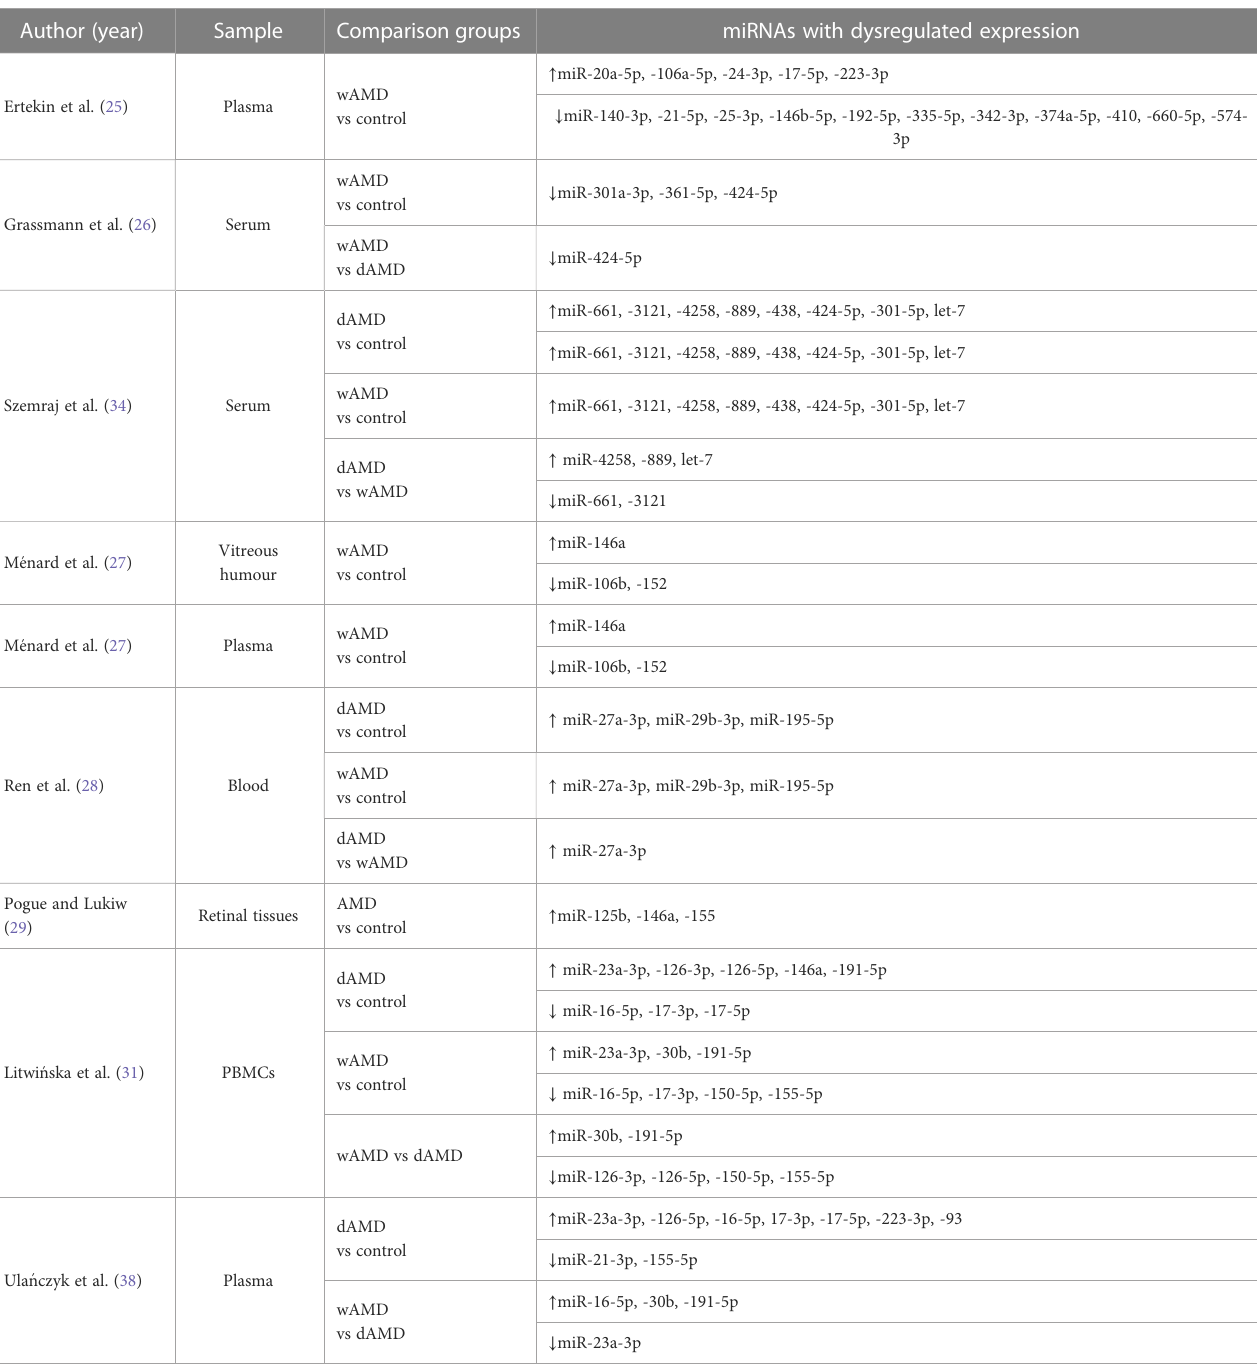
TABLE 1 Summary of identi fi ed miRNAs with dysregulated expression in AMD patients. Author